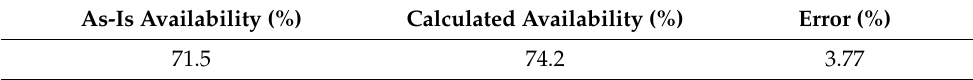
Table 3. Performance analysis of the system.